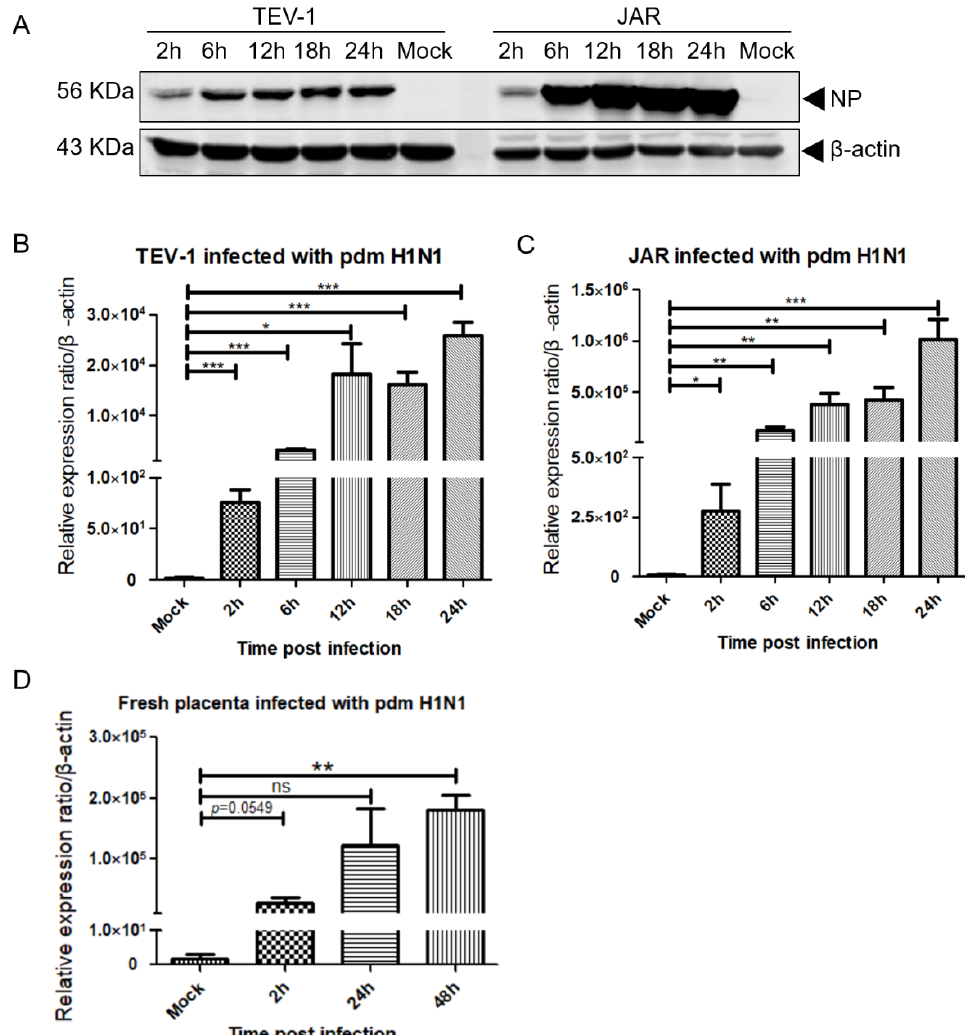
Figure 6. The detection of NP protein and viral M2 RNA in an H1N1/09-infected human placenta. A mouse anti-influenza A virus NP antibody was used to detect the nucleoprotein, and a β -actin antibody was used as an internal control ( A ). Quantification of viral M2 RNA in H1N1/09-infected TEV-1 ( B ), JAR ( C ) cells and placenta tissue ( D ), using real-time PCR. Data are presented as mean ± SEM, n = 3–6, * p < 0.05, ** <0.01, *** <0.001 versus mock-infected; ns, non-significant.